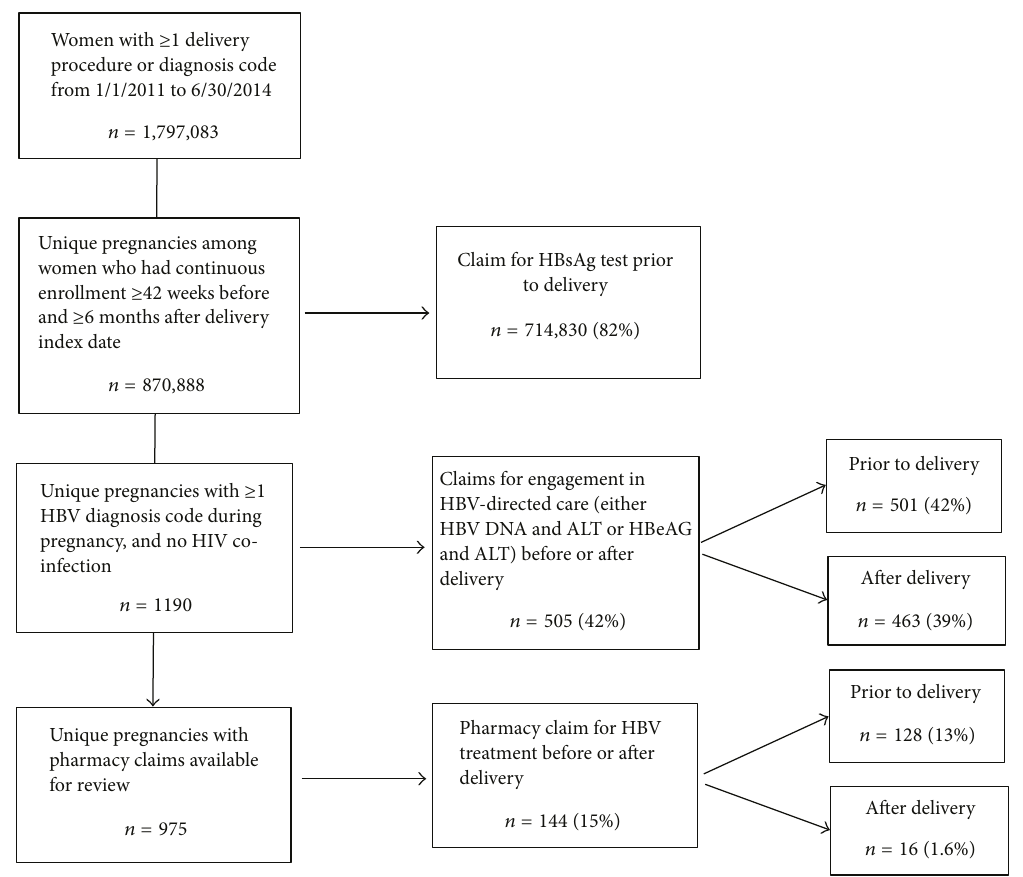
Figure 1: Flow chart of study criteria and cascade of hepatitis B testing, care, and treatment among pregnancies in MarketScan,